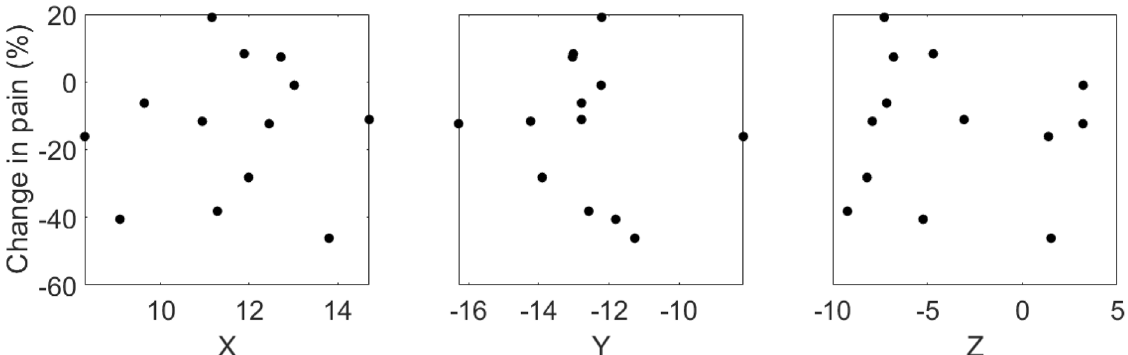
Figure 4. Percent change in pain from 20 Hz DBS plotted against active contact location in MNI coordinates